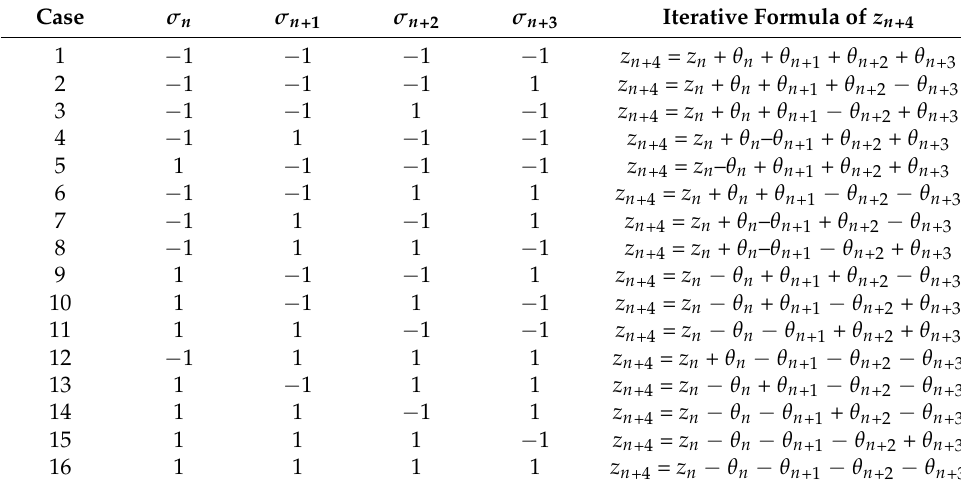
Table 2. Corresponding iterative formula of z n +4